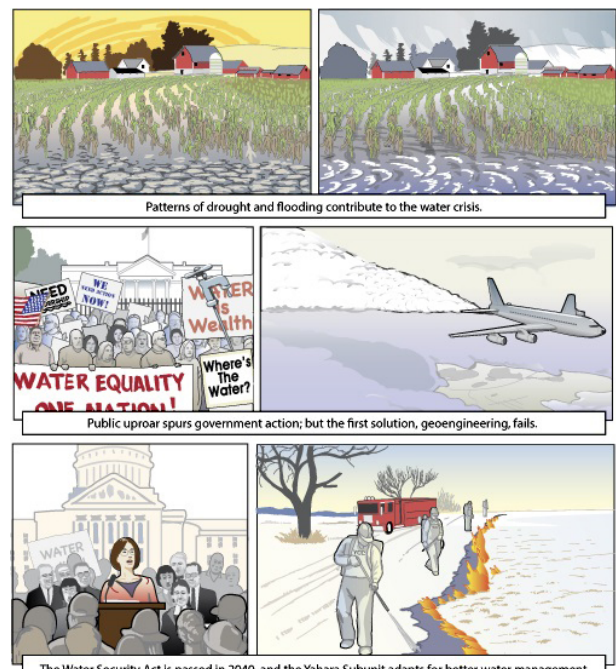
Fig. 8. Timeline of major events in the “Nested watersheds”